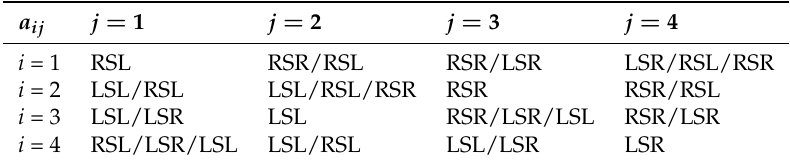
Table 2. Decision table for shortest 2D Dubins curves based on the quadrant numbers of the starting and ending